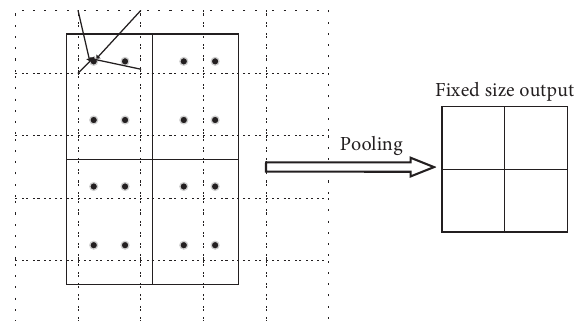
Figure 3: Bilinear interpolation in RoIAlign, where the dashed background grid represents the feature map, the solid grid rep- resents an RoI (with 2 × 2 bins in this example), and the dots represent the four sample points in each